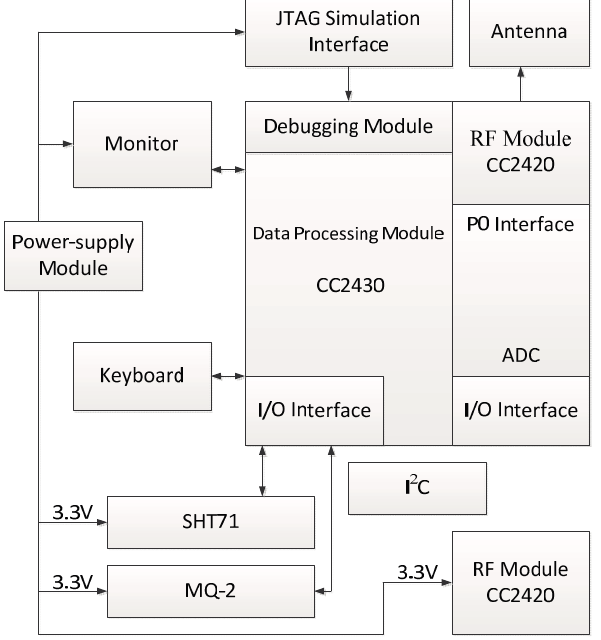
Figure 8. The whole design diagram of the